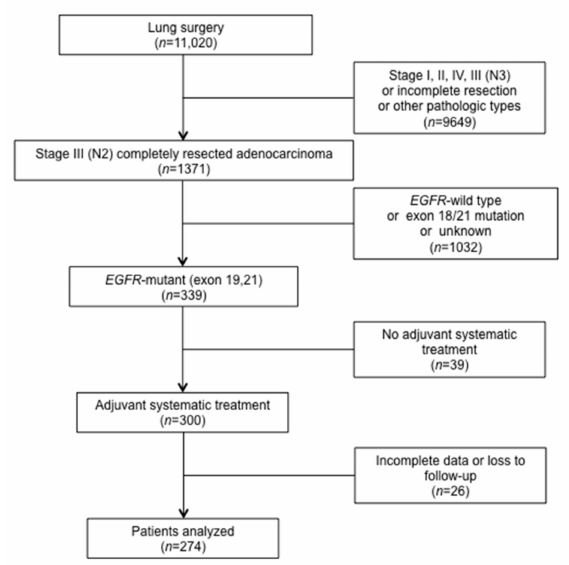
Figure 1. Flowchart for patient enrollment. EGFR : epidermal growth factor